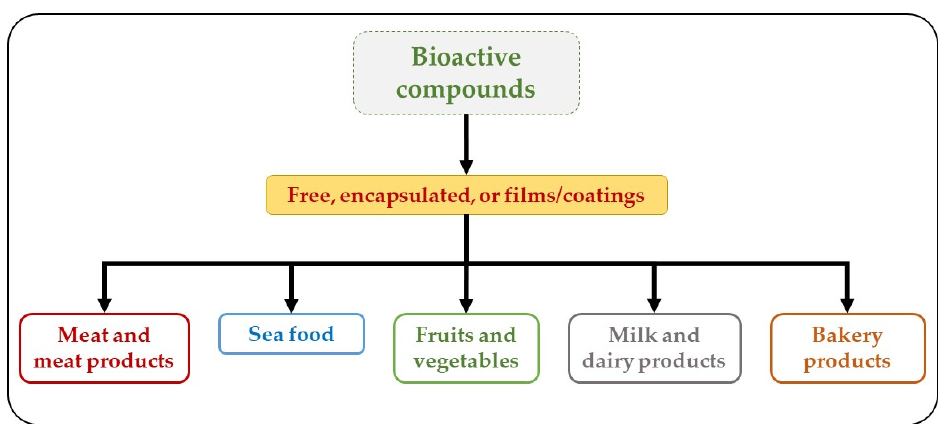
Figure 2. Schematic representation of the use of bioactive compounds from fruits as food preservatives.